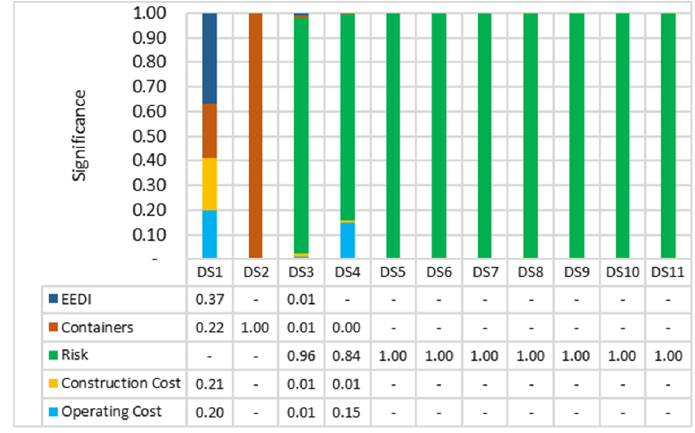
Figure 12. Significance of design criterion.